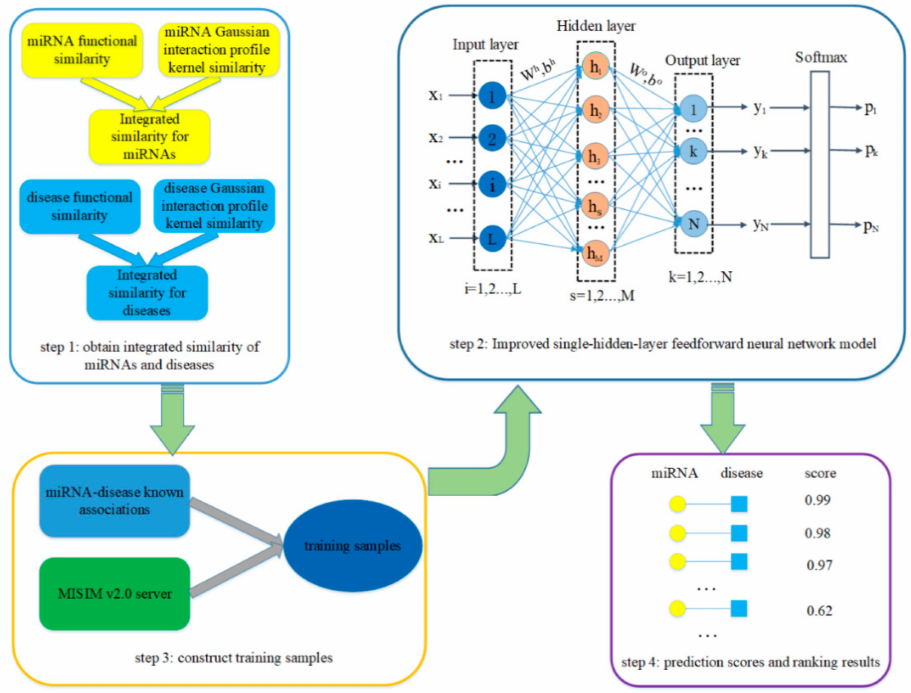
Figure 1. The main framework of the RNSSLFN prediction